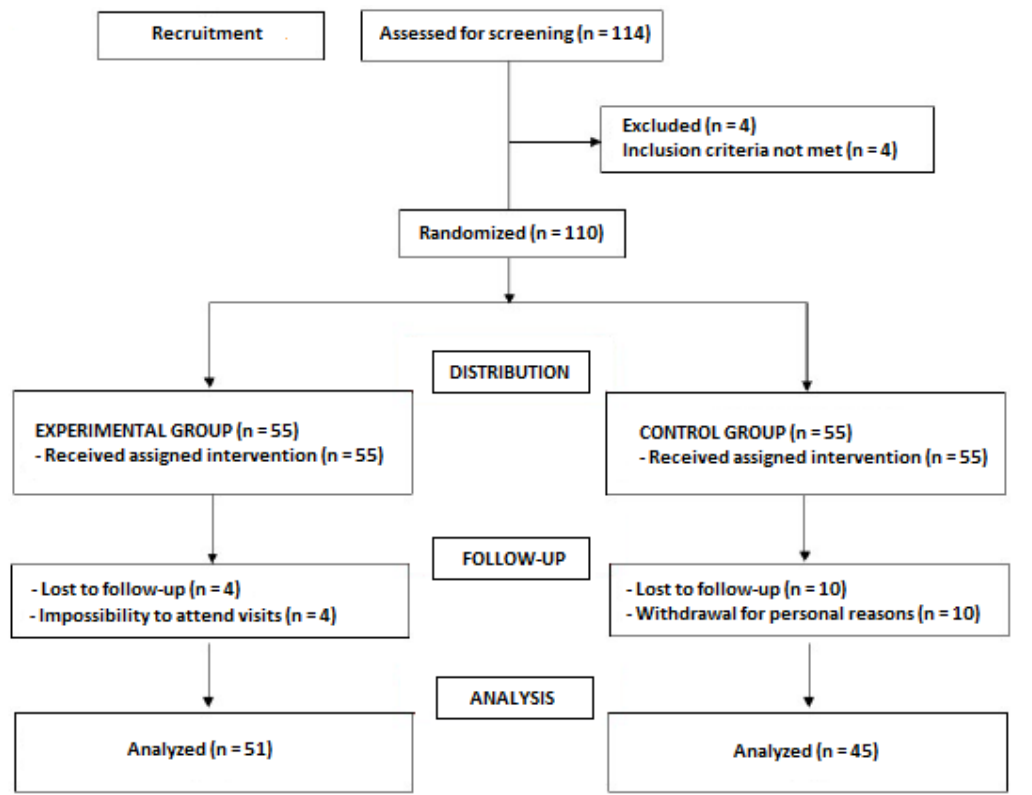
Figure 1. Flow chart of the study population.